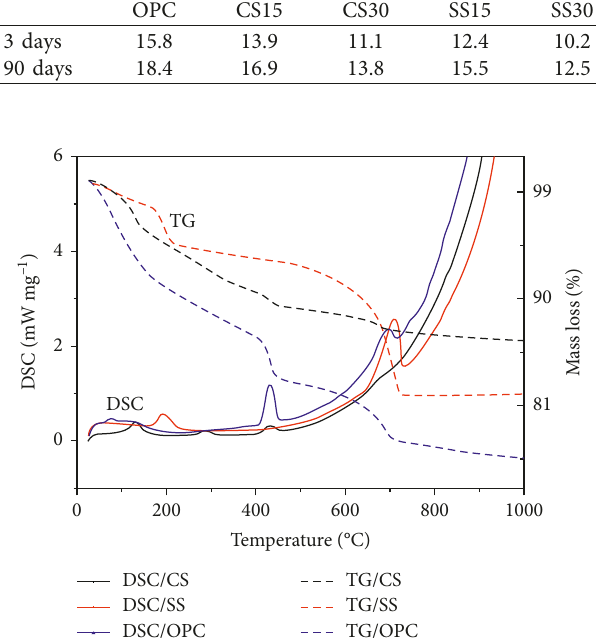
Figure 7: TG/DSC curves for pure OPC, CS, and SS at 90